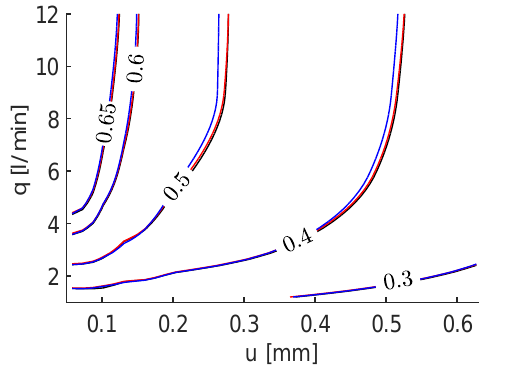
Figure 5: C d (u,Re) for HV at 20(black), 40(red),